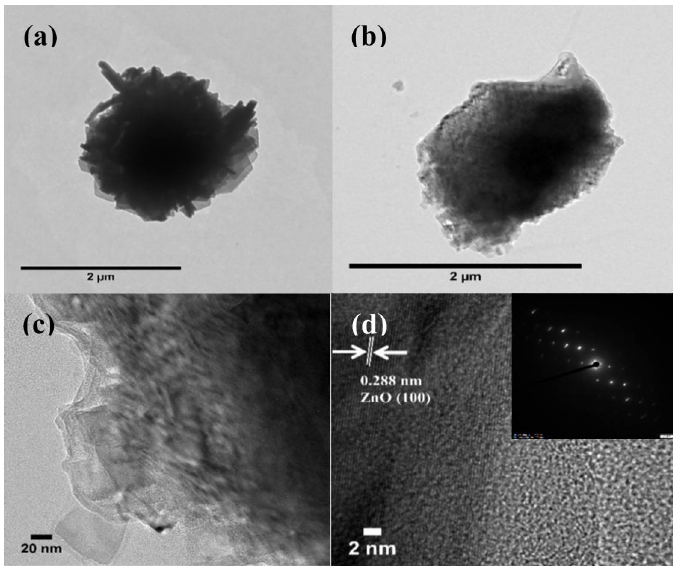
Figure 11. TEM image ( a ), HR-TEM images ( b – d ), and SAED image (inset) of ZnO@MOF-46(Zn) sonicated for 30 min and left at room temperature for 48 h.